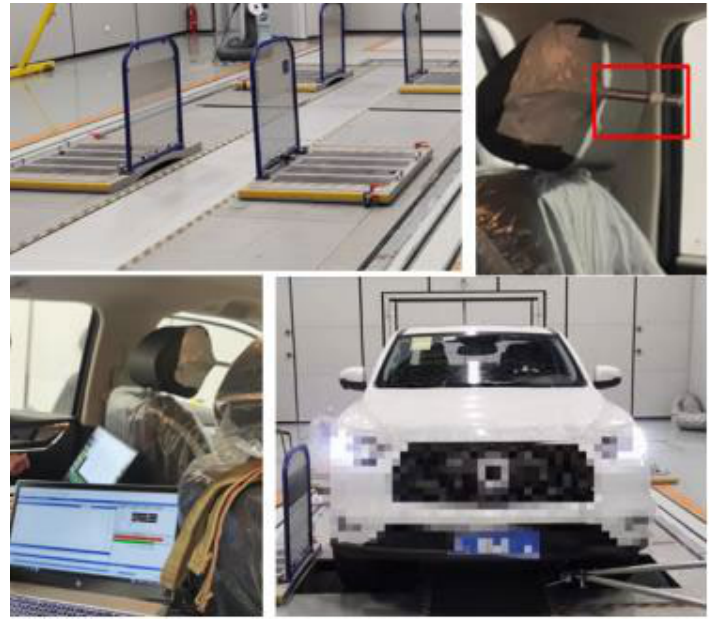
Figure 4. In-vehicle noise collection test environment.